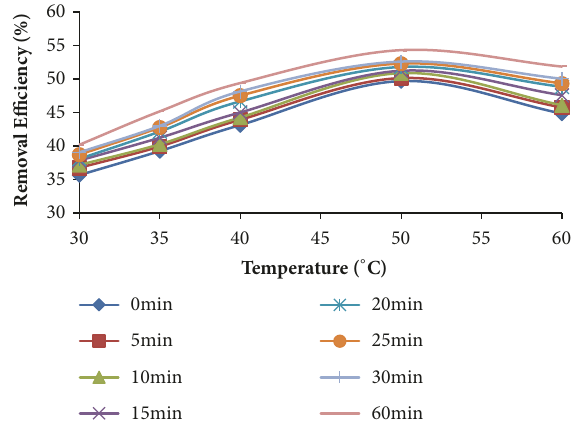
Figure6:Effectoftemperature,atvaryingtimeforPOMEatcurrent density of 3A and pH of